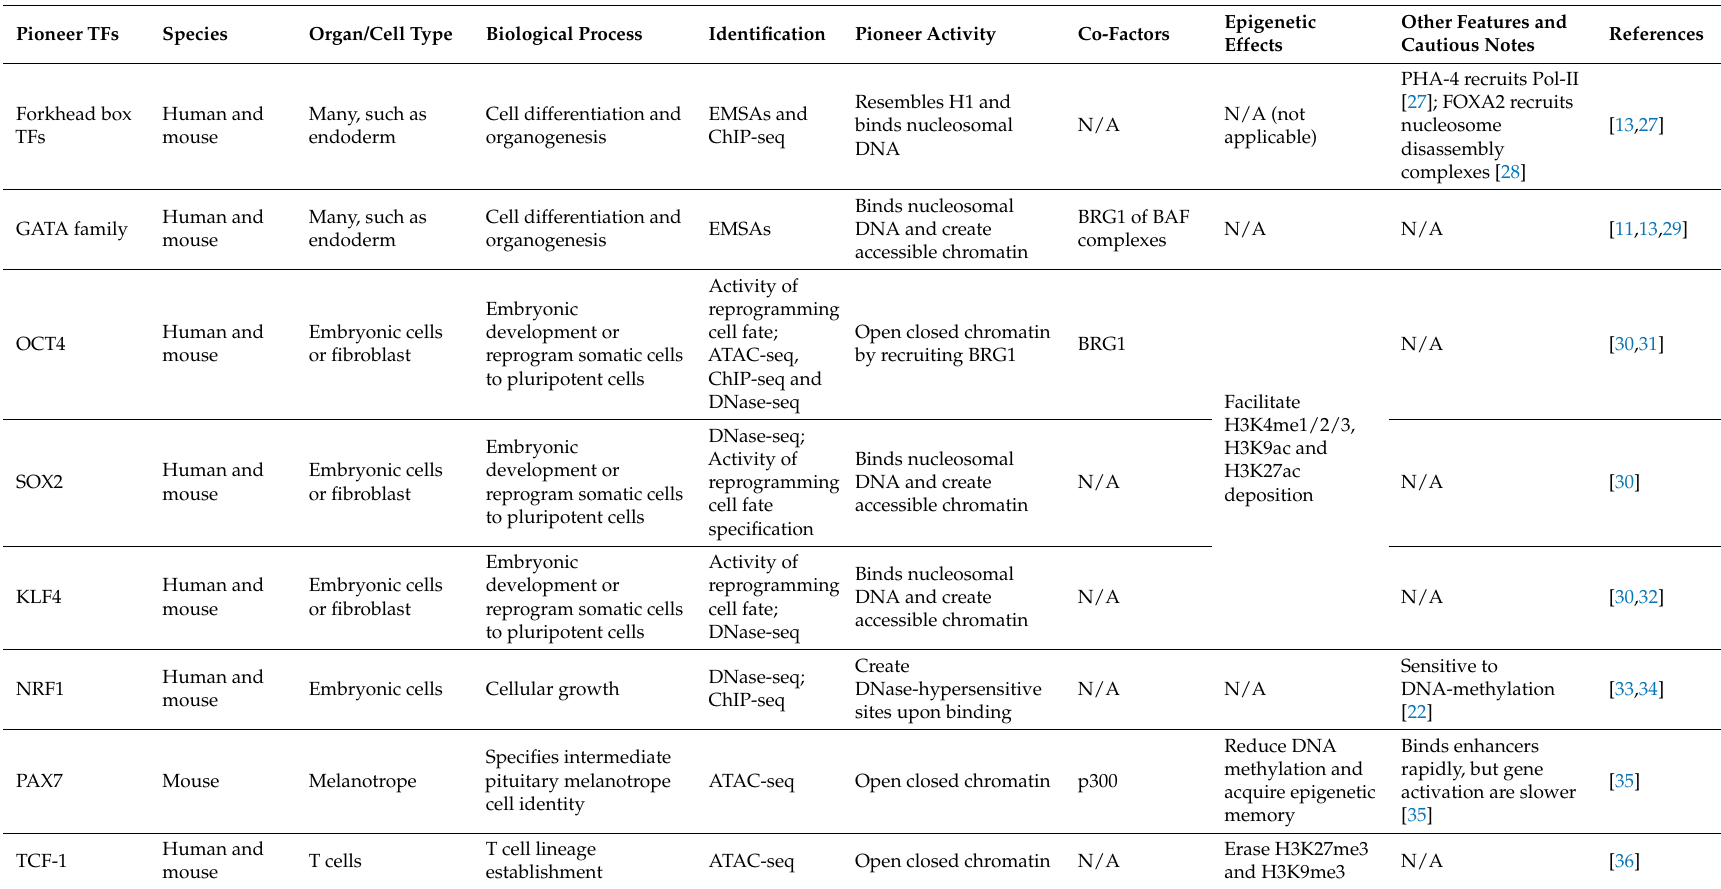
Table 1. Pioneer factors in animals